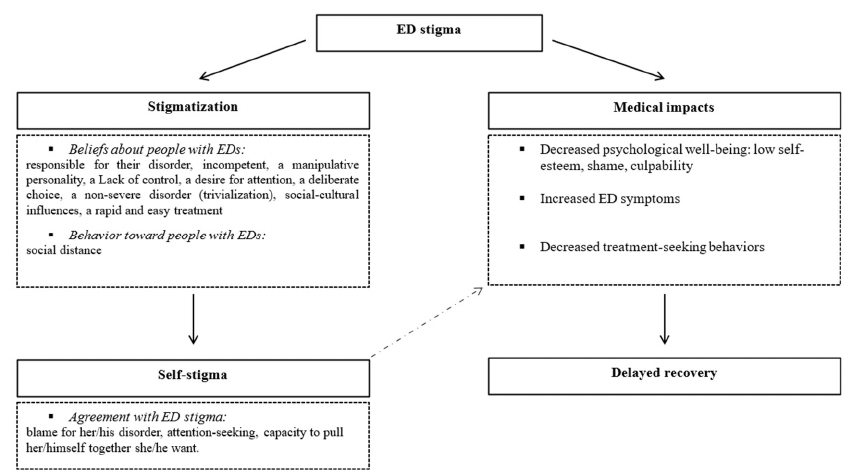
Figure 2. Consequences of stigma against people with eating disorders (EDs).